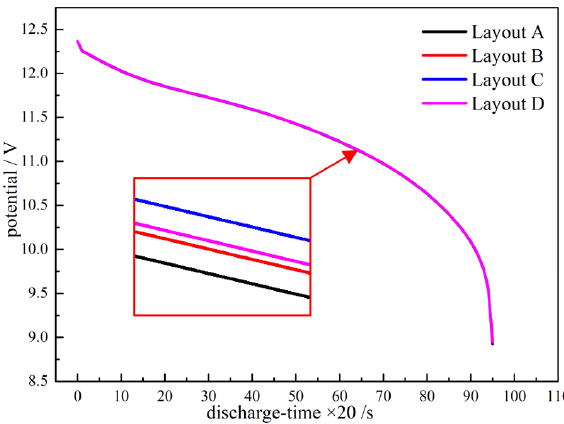
Figure 4. Potential curves of different terminal layouts at the positive tab.